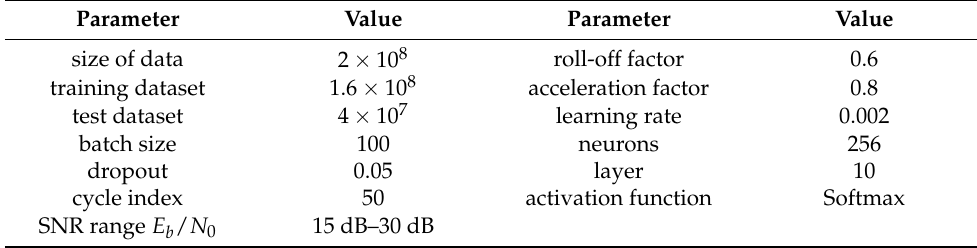
Table 1. Summary of simulation parameters.